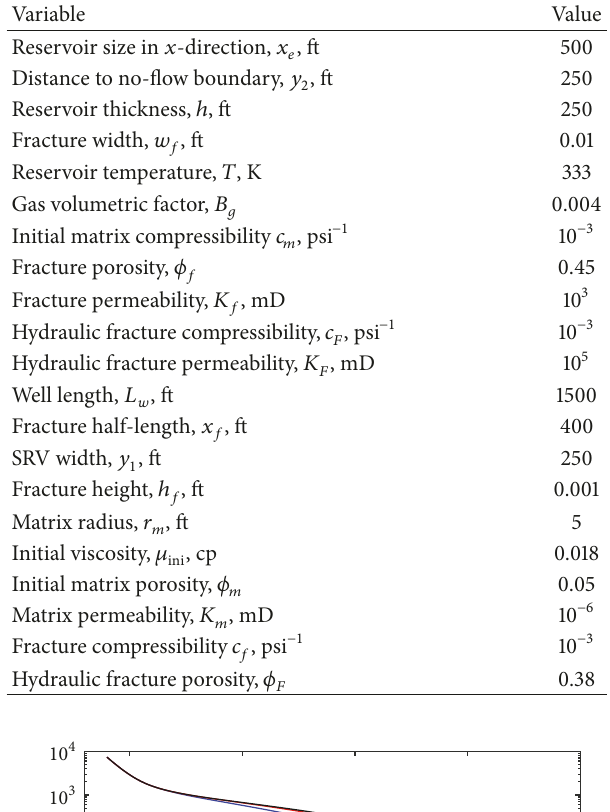
Table 3: Model parameters.